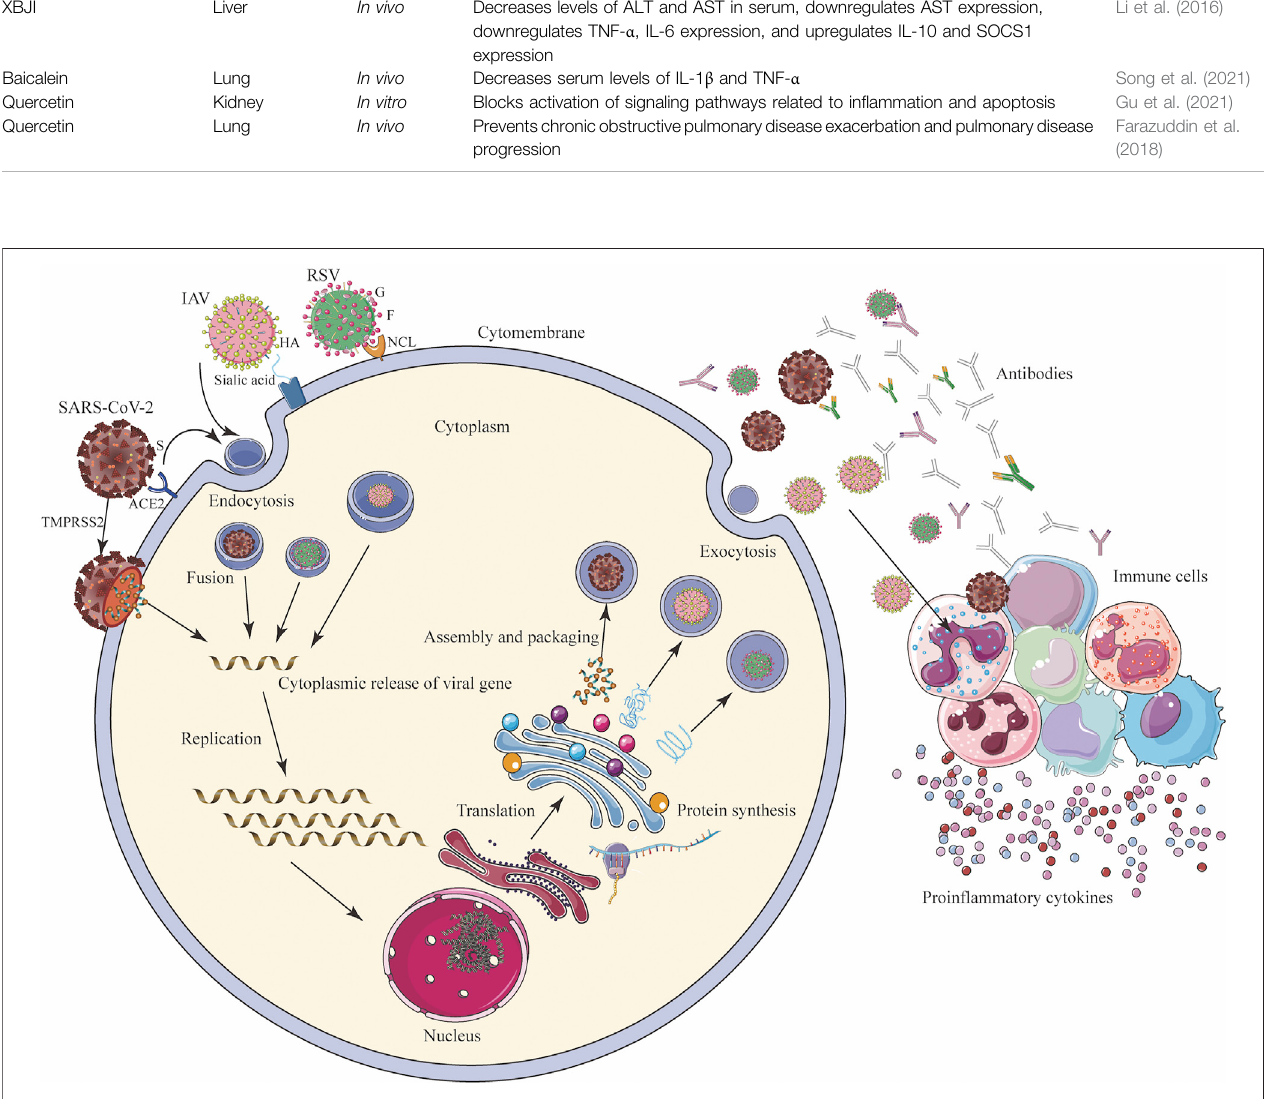
FIGURE2| Mechanismofviralinfection(SARS-CoV-2,IAV,andRSV)ofhostcellsandhostimmuneresponse.SARS-CoV-2bindstoACE2,andIAVinteractswith sialic acid through the HA on the surface and enters the host cells by endocytosis, and SARS-CoV-2 can directly enter cells under the action of TMPRSS2.G protein on the surface of RSV adheres to the cell membrane, and F protein binds to NCL and endocytosis into cells. After entering the cell, the virus releases its genome in the cytoplasm. Through transcription and translation in the nucleus, it isexported to the nuclear endoplasmic reticulum and ribosomesfor the synthesis and assembly ofviralproteins, and fi nallyformsnewprogenyvirusparticles, whichareexported totheoutsideofthecellintheformofexocytosis,andthehost ’ simmunesystemWhile beingactivated, immunecellssecretealargenumberofantibodiesandcytokinesto fi ghtthevirus.ACE2:angiotensinconvertingenzyme2;HA:hemagglutinin;G:glyco protein; F: fusion protein; NCL: nucleolin receptor; S: spike protein; TMPRSS2: transmembrane protease, serine